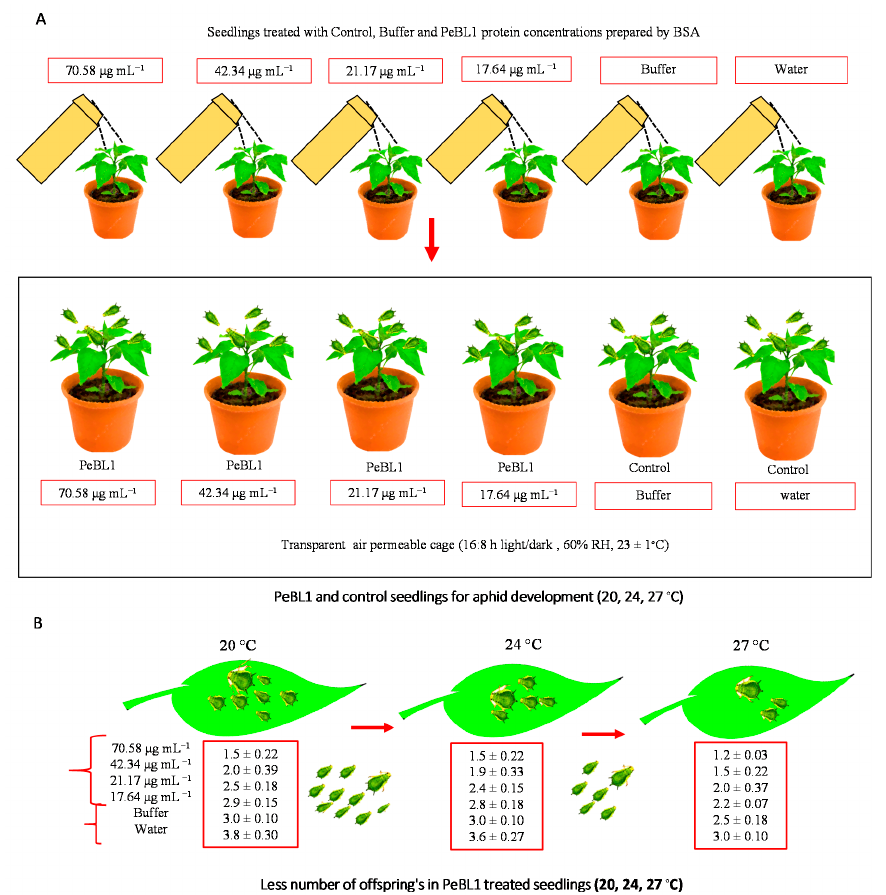
Figure 4. M. persicae fecundity reduced in PeBL1-treated cucumber seedlings. ( A ) Seedlings treated with control, bu ff er, and PeBL1 protein concentrations prepared by BSA. ( B ) PeBL1 and control seedlings for aphid development (20, 24, and 27 ◦ C). Average fecundity of M. persicae on cucumber plant in relation to various PeBL1 concentrations at di ff erent temperature regimes ( n = 10). Data are shown as mean ( ± SE). Data were compared statistically by a factorial ANOVA and LSD at α = 0.05 in Statistix, version 8.1. Letters on each bar’s top show significant di ff erences among treatments.